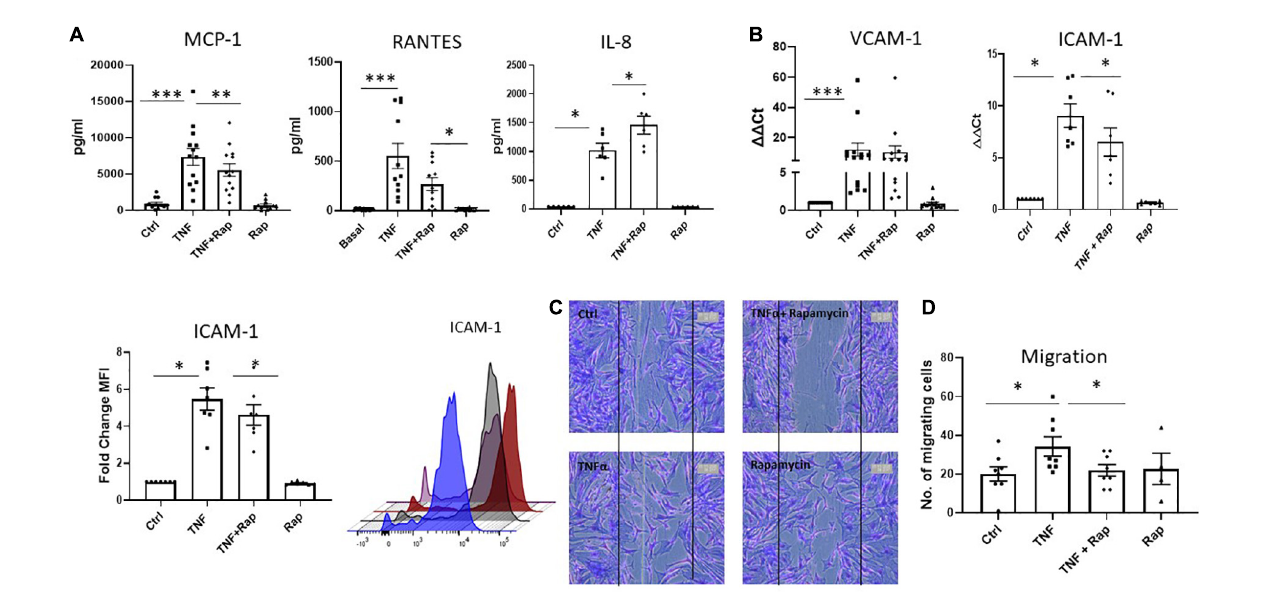
FIGURE3 mTOR inhibition in RA synovial fibroblasts decreases cellular migration. Bar graphs showing the measured secretion of (A) MCP-1, RANTES, and IL-8 from RASF ( n = 6–13) and mRNA expression of (B) VCAM-1 and ICAM-1 in RASF ( n = 7–14) treated with TNF α (1 ng/ml) and Rapamycin (100 nM) alone or in combination for 24 h. Gene expression analysis quantified using Real-time PCR. Fold increase compared to endogenous controls (RPLPO and HPRT1). Fold change MFI expression of ICAM-1 on RASF ( n = 7). (C) Representative photomicrographs and (D) accompanying bar graph demonstrating cells repopulating the wound to represent migration. Images were taken of RASF ( n = 8) after being treated with TNF α (1 ng/ml) and Rapamycin (100 nM) alone or in combination for 24 h. Values expressed as mean ± SEM, Wilcoxon signed rank test used for RASF. ∗ p < 0.05, ∗∗ p < 0.01, ∗∗∗ p <